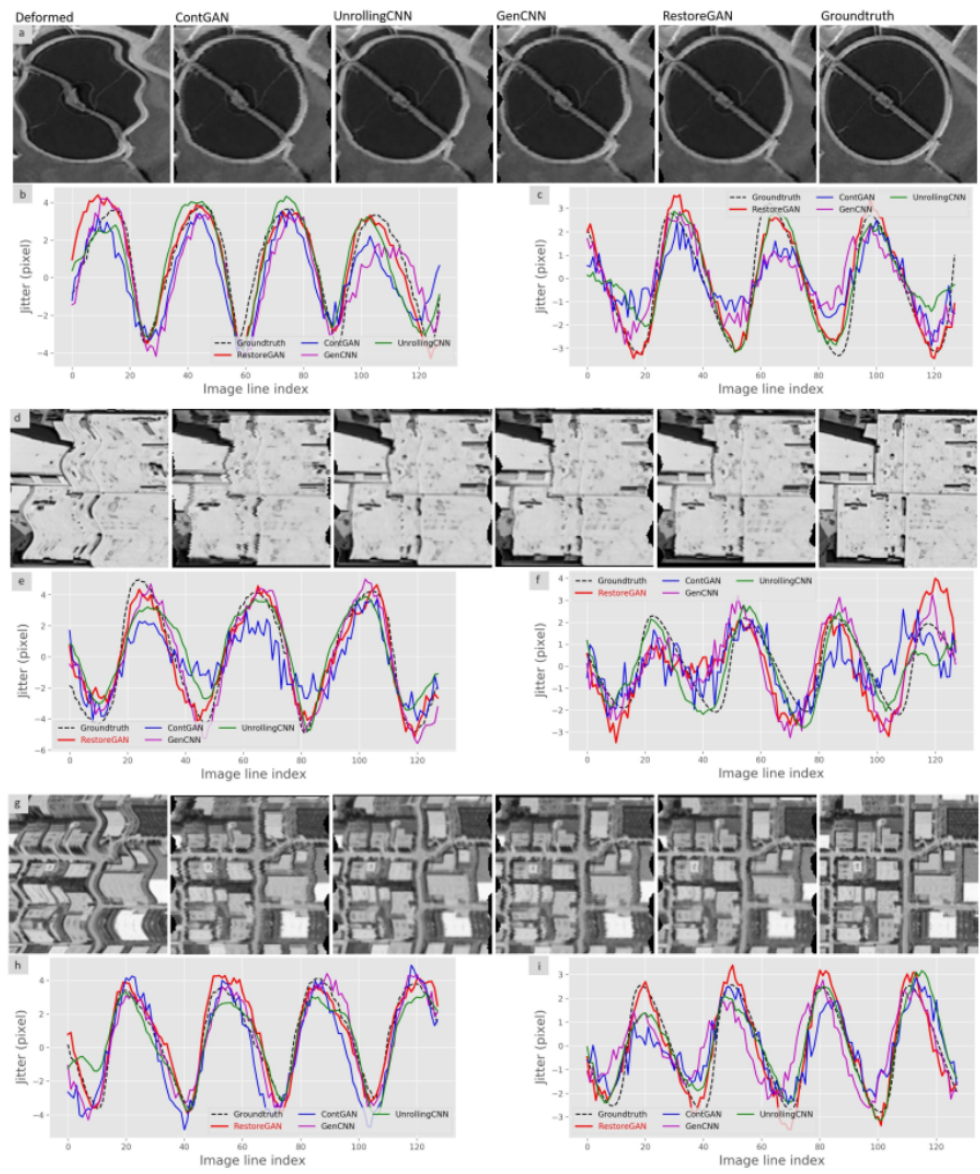
Figure 9. Restoration results of different models on the three datasets. ( a ): Restoration results on the wastewater treatment plant image of the PatternNet dataset; ( b ): Corresponding jitter in the x direction; ( c ): Corresponding jitter in the y direction; ( d ): Restoration results on the building image of the UCMerced dataset; ( e ): Corresponding jitter in the x direction; ( f ): Corresponding jitter in the y direction; ( g ): Restoration results on the industrial image of the WH-RSU19 dataset; ( h ): Corresponding jitter in the x direction; ( i ): Corresponding jitter in the y